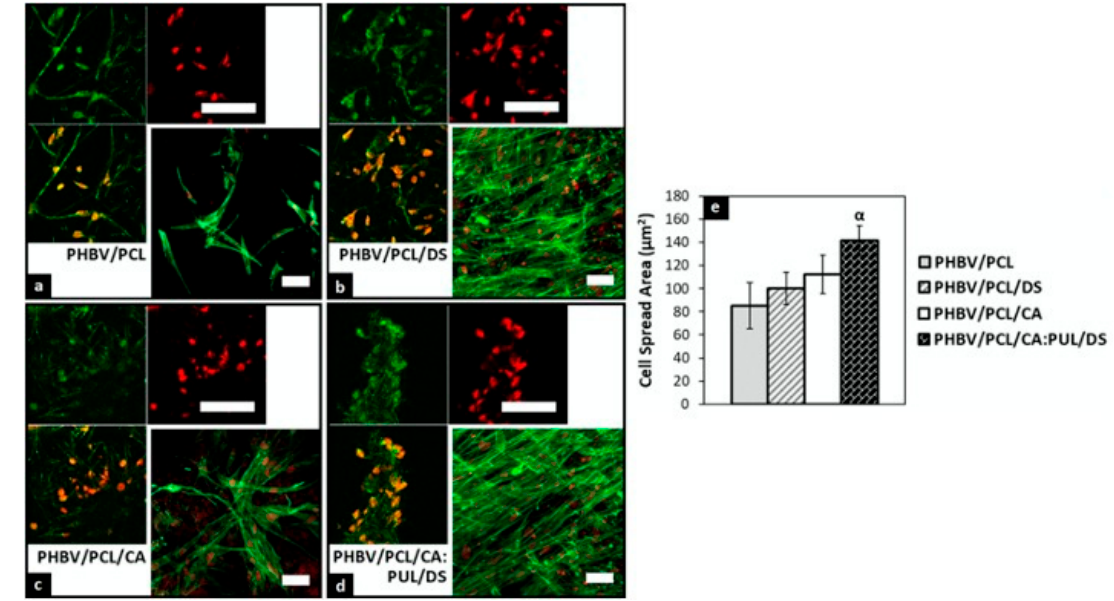
Figure 5. Laser scanning confocal microscopy images of Saos-2 cells on PHBV/PCL ( a ), PHBV/PCL/DS ( b ), PHBV/PCL/CA ( c ), and PHBV/PCL/CA: PUL/DS ( d ) scaffold groups after 7 days of incubation, ( e ) Cells spread area. Green and red colors are representing Alexa Fluor 4. Reproduced from Reference [92], copyright (2019), with permission from Elsevier.